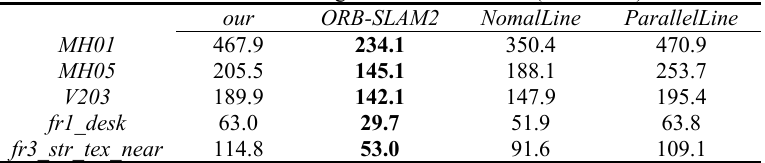
.The larger the threshold 𝛼𝛼